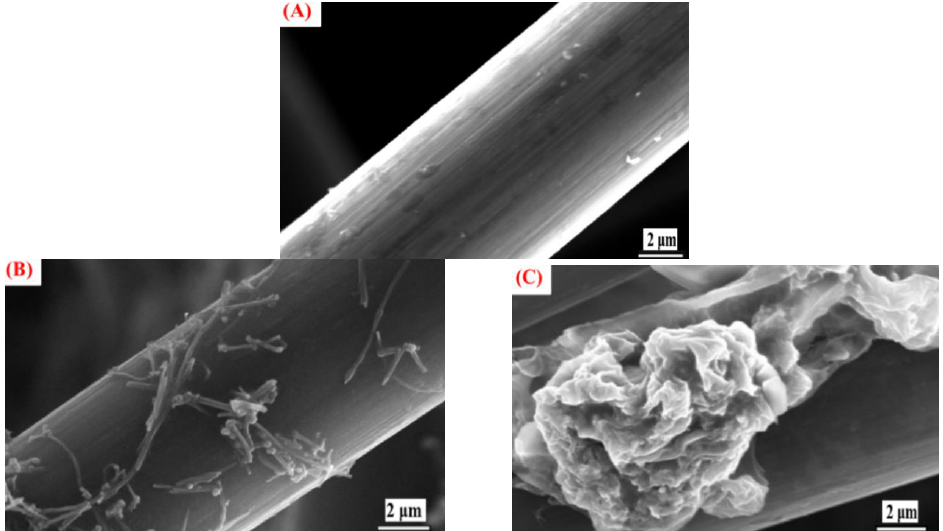
Figure 2. SEM images of carbon felt: ( A ) Unmodified carbon felt magnified 7000 times, ( B ) carbon nanotube (CNT)/C magnified 7000 times, and ( C ) graphene/C magnified 7000 times.